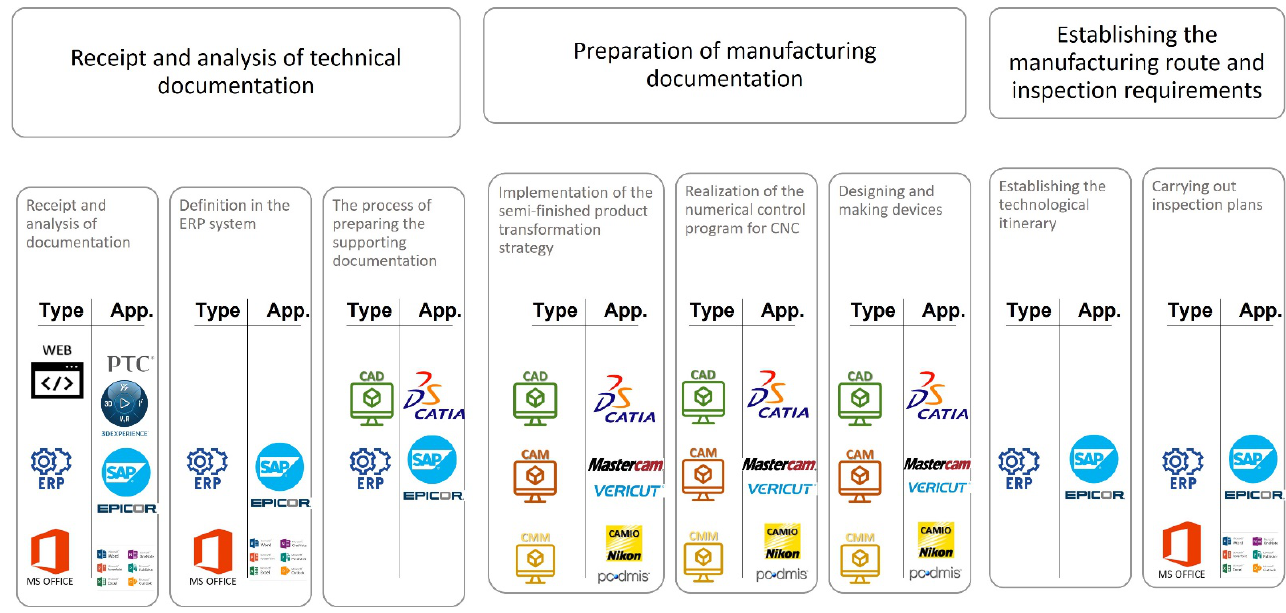
Figure 7. Distribution of the types of IT applications used in the global engineering process.